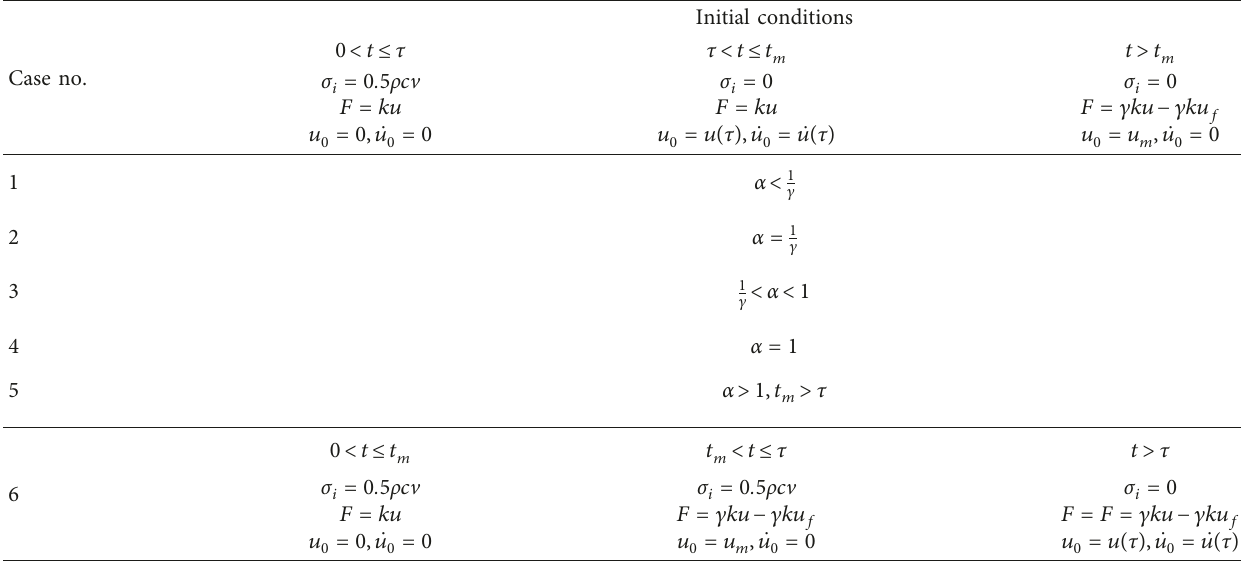
Table 1: Expansion conditions for dynamic drill-bit properties for loading, unloading, and stress-wave duration, τ .